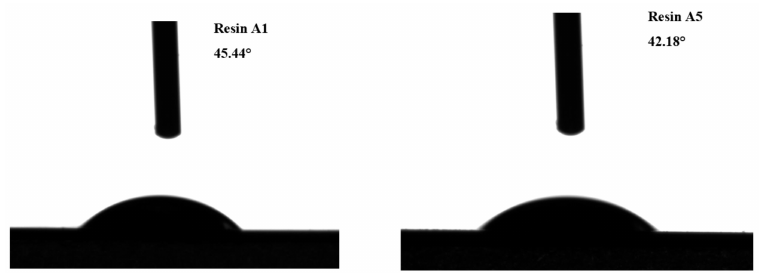
Figure 7. Water contact angles of Resin A1 and Resin